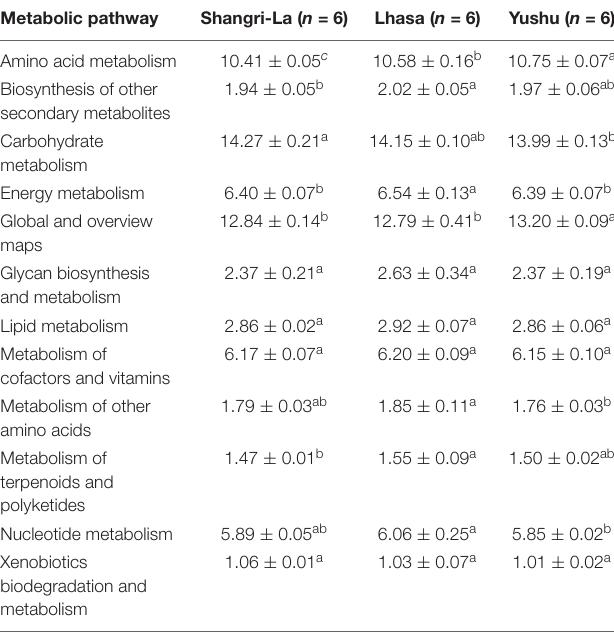
TABLE 2 | Predicted functional composition (%) of microbiota relating to metabolism.